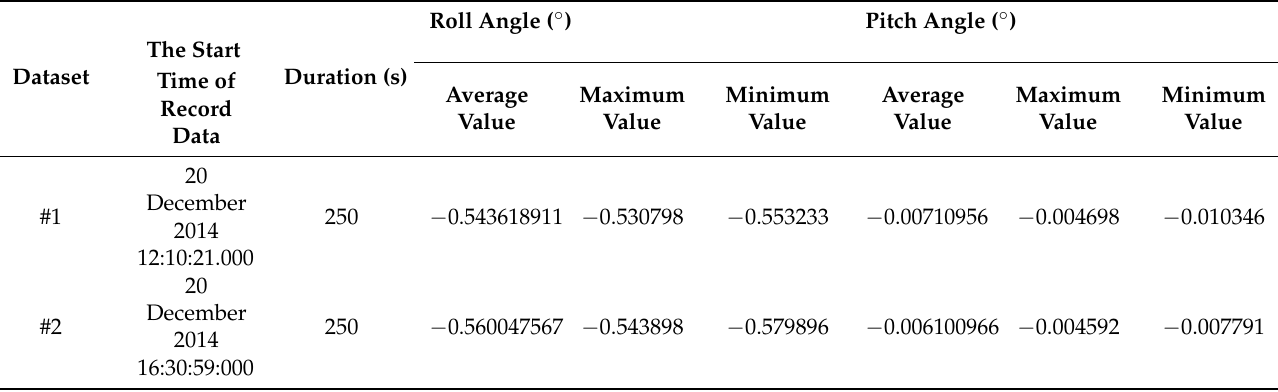
Table 1. The description of different raw